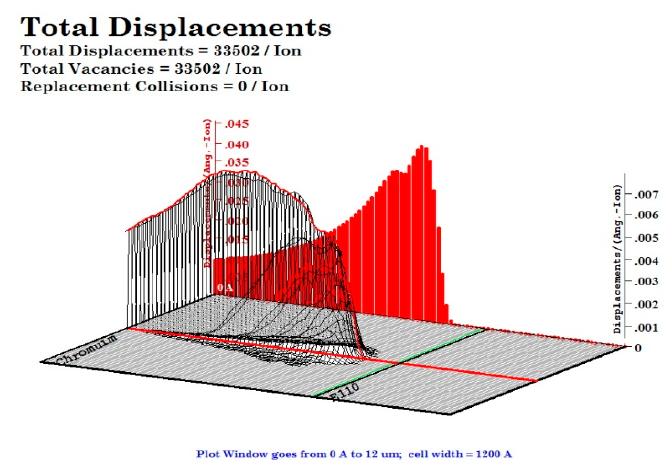
Figure 17. Damage caused by 90 MeV Iodine in E110 alloy, coated with 8 µm Cr thin film.